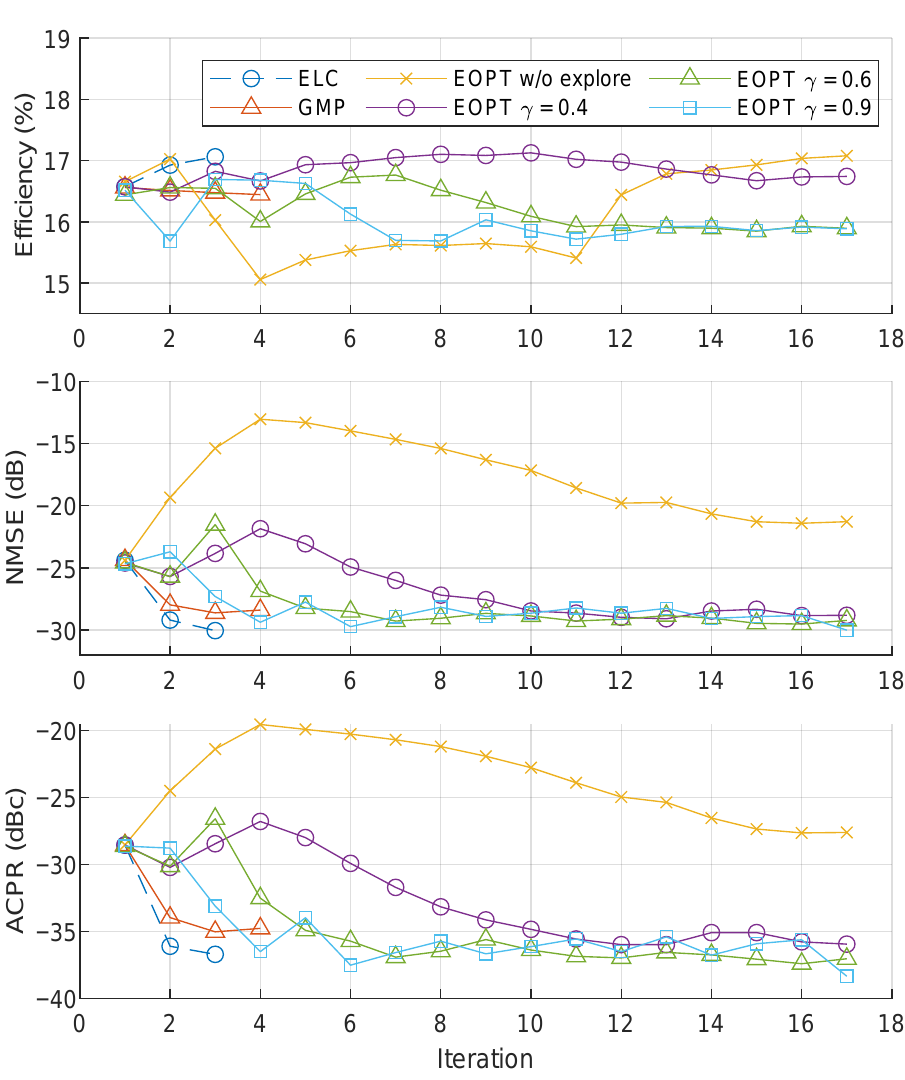
Figure 9. Power efficiency, NMSE, and ACPR performance per iteration of different linearization